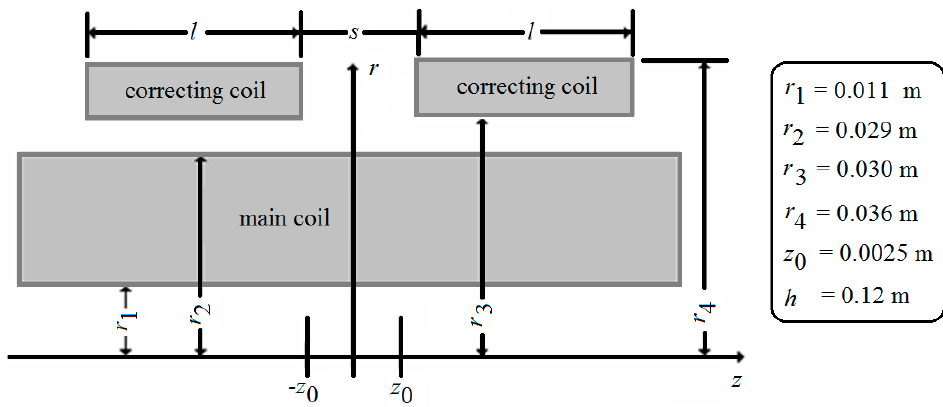
Figure 1. Upper half-plane of the axial cross-section of Loney’s solenoid.